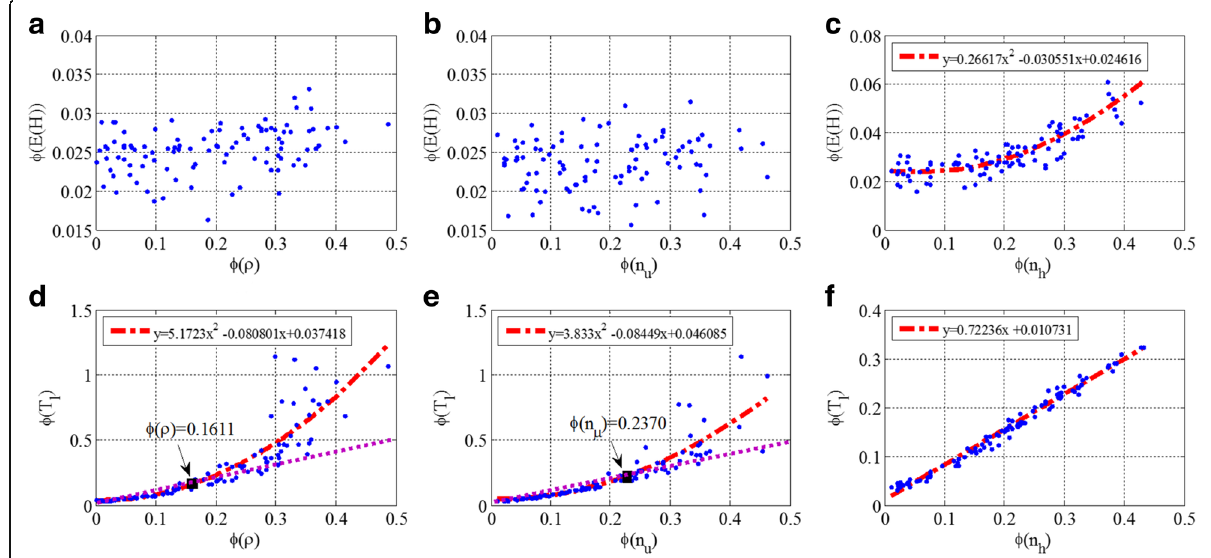
Fig. 13 Comparisons of fluctuation coefficients of the parameters. a Shows the fluctuation effect of ρ to E ( H ). b Shows the fluctuation effect of n u to E ( H ). c Shows the fluctuation effect of n h to E ( H ). d Shows the fluctuation effect of ρ to T l . e Shows the fluctuation effect of n u to T l . f Shows the fluctuation effect of n h to T